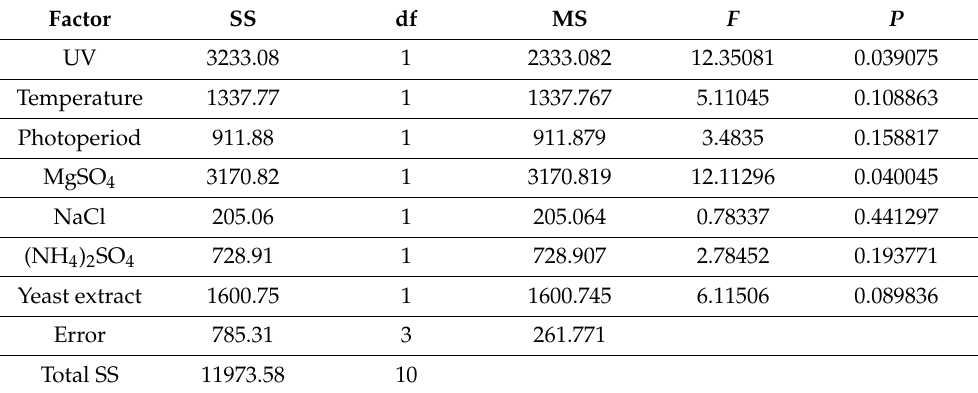
Table 2. ANOVA results of the different cellular stress factors analyzed using a Plackett–Burman design. Factor SS